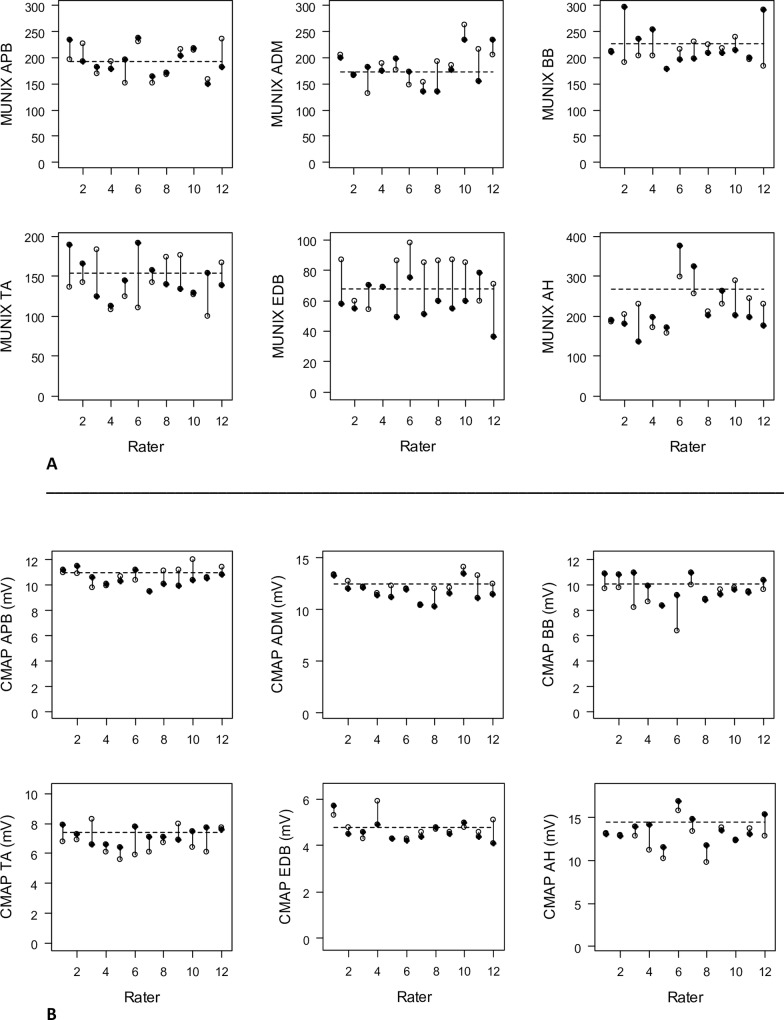
A and B: Test-retest results for MUNIX (A) and CMAP (mV) (B) in individual muscles. The dotted lines indicate the hypothetical reference value. Note the different y-axis scales for each muscle. Open dots = test values, filled dots = retest values.